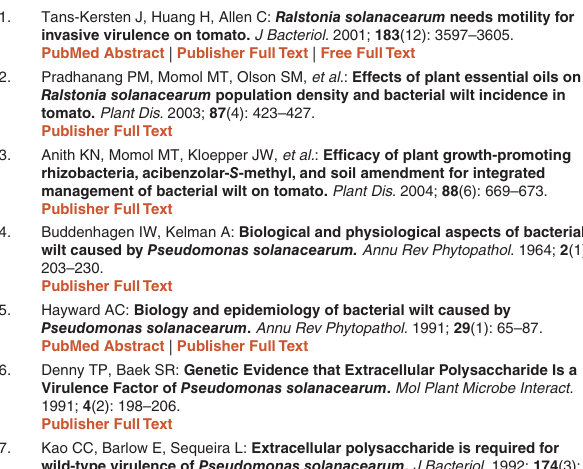
Figshare: Images of the plates showing the zone of inhibition by different antagonists against Ralstonia spp. Clear zone of inhibition obtained by agar well diffusion technique indicates the bioefficacy of the selected bioantagonists against Ralstonia spp. https://doi.org/10.6084/m9.figshare.5562058.v3 49 Figshare: Raw digital images (400X) of microscopic analysis representing the interactions of different antagonist against Ralstonia spp. Collection of raw images obtained from digital microscopy in both dark field and bright field microscopy at 400 X zoom. https://doi.org/10.6084/m9.figshare.5561968.v2 50 Figshare: Field Images of plot design showing pictures of before the treatment and effects after the treatment. There is signifi- cant decrease in the occurrence of disease for the treated plots whereas the bacterial wilt has severely affected in the untreated plot. https://doi.org/10.6084/m9.figshare.5562373.v2 51 Data are available under the terms of the Creative Commons Attribution 4.0 license (CC-BY